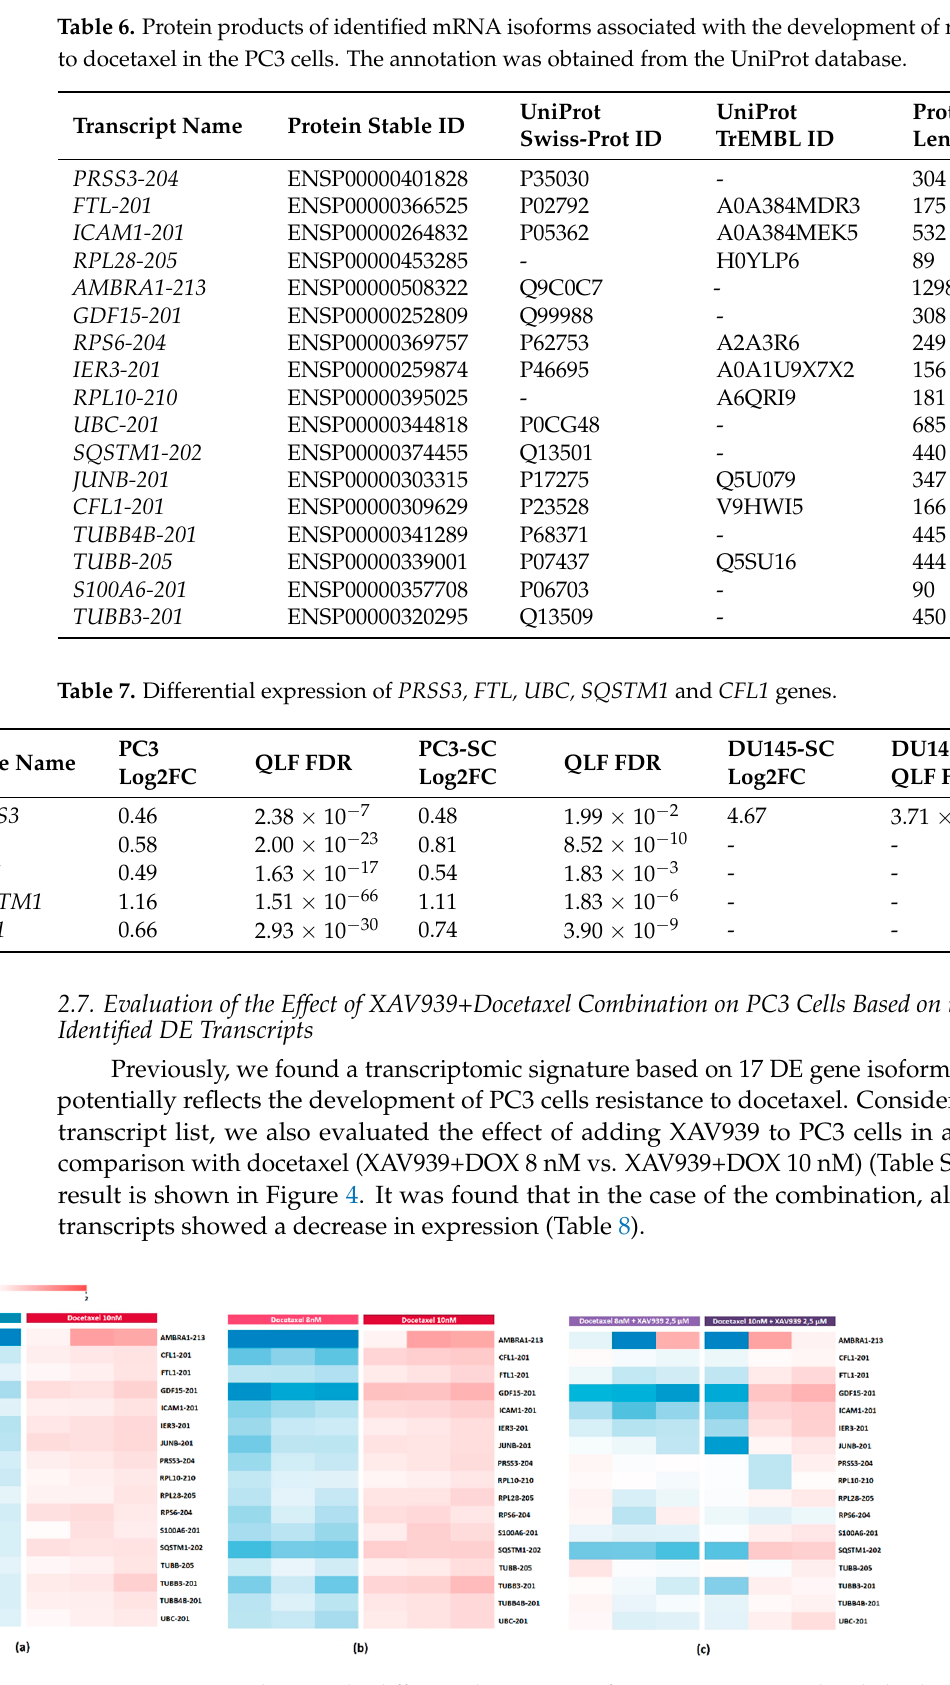
Figure 4. Heat map showing the differential expression of transcripts associated with the development of resistance to docetaxel treatment on PC3 cells ( a ) compared to the control ( b ) after 8 nM versus 10 nM docetaxel treatment ( c ) after 8 nM versus 10 nM docetaxel treatment in combination with XAV939. Cell colors (blue–white–red gradient) correspond to the binary logarithm of the ratio of the expression level in a current sample to the average level across all the samples (per each transcript). Blue, expression level is below the average; red, above the average. Table 8. Differential expression of transcripts potentially associated with the development of re- sistance to docetaxel treatment when PC3 cells are treated with XAV939+Docetaxel combination. Transcript ID